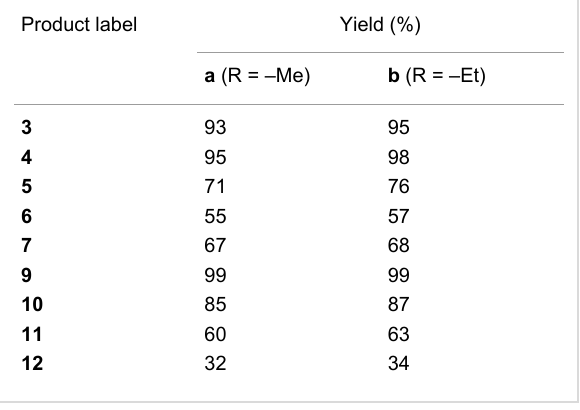
Table 2: Representative compounds prepared via Schemes 1, 2 and